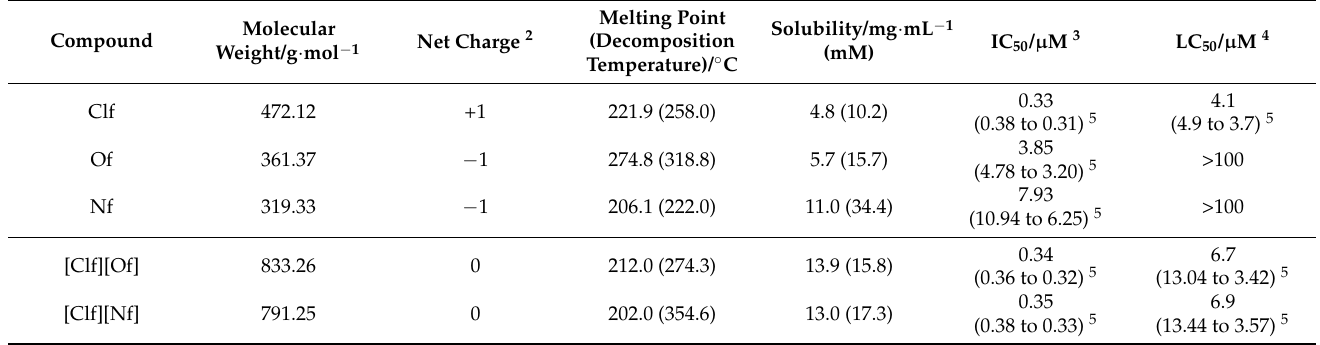
Table 1. Physico-chemical properties and in vitro effects of the API-OSs and their parent drugs. The compounds were tested against both axenic cultures of M. avium 2447 SmT (IC 50 ) and mammalian host cells (bone marrow-derived macrophages, BMM, LC 50 ) infected with M. avium 2447 SmT. 1 .